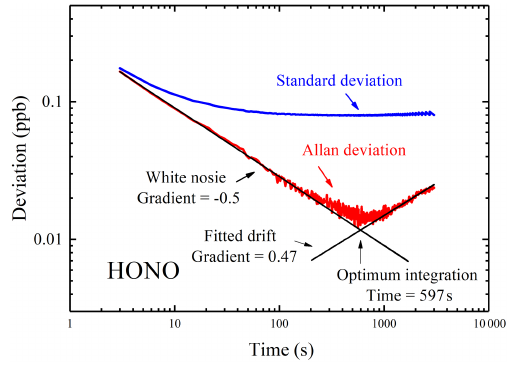
Figure 6. Standard deviation and Allan deviation plots for measure- ments of HONO. For integration times of below 110 s the Allan √ t (gradient of − 0 . 5). The deviation decreases approximately as minima of the Allan deviation indicate the optimum averaging time for maximum detection